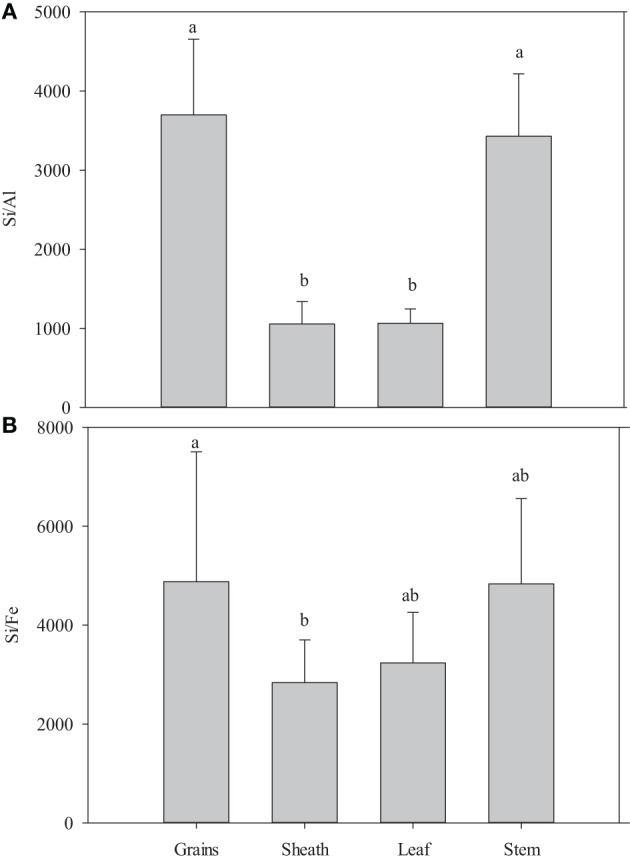
The ratio of Si/Al (A) and Si/Fe (B) in phytoliths of five rice cultivars. Means with various letters are significantly different at the p < 0.05 level of confidence according to Duncan's Multiple Range Test.